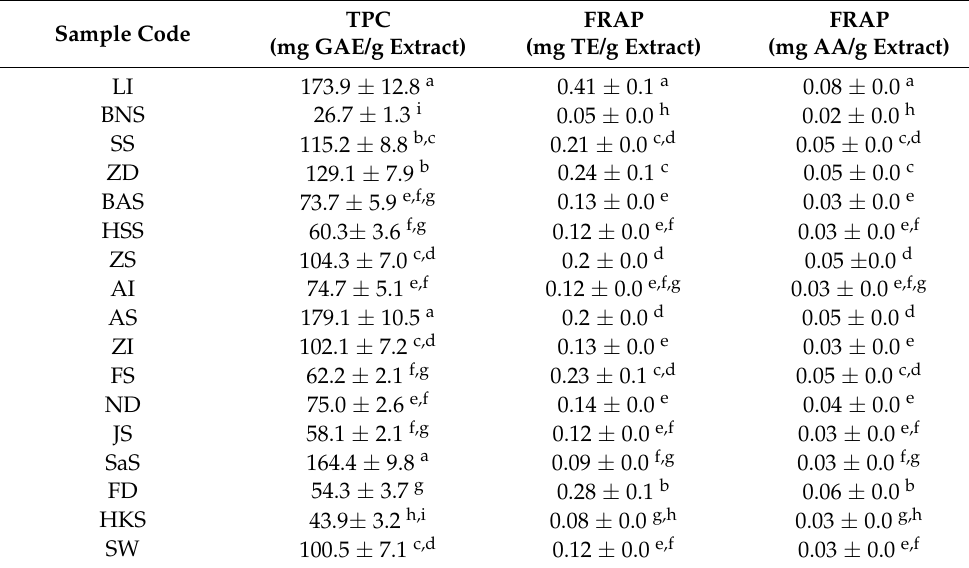
Table 3. List of total phenolics content (TPC) and antioxidant effect activity using FRAP assay for investigated Egyptian mango. The results are expressed as mean ± SD ( n = 3). The sample code is listed in Table 1.